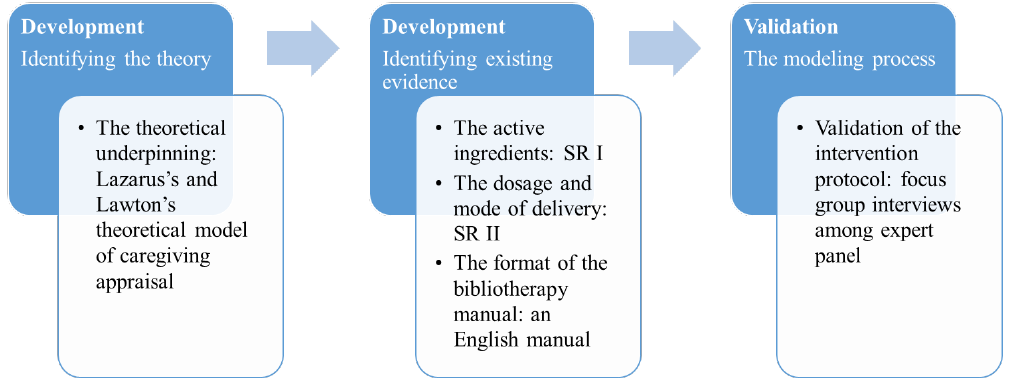
Figure 1. Methodological approach to developing an evidence-based bibliotherapy protocol.